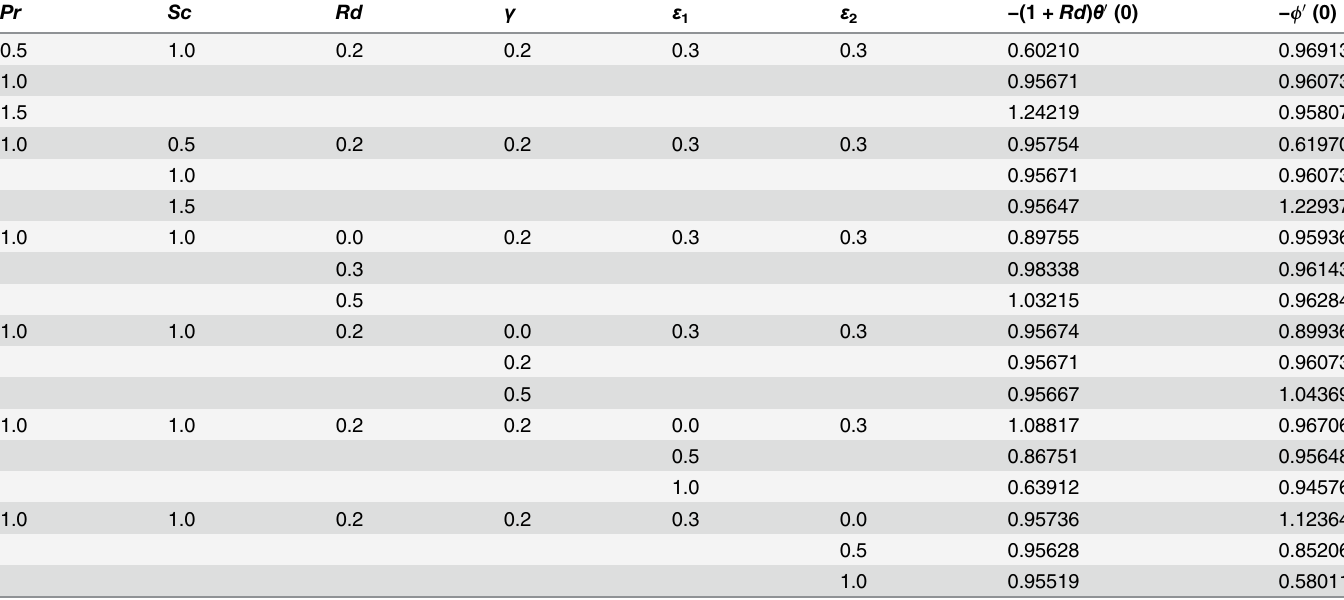
Table 3. Values of local Nusselt number (Re x ) − 1/2 Nu x and local Sherwood number (Re x ) − 1/2 Sh x for different values of Pr, Sc , Rd , γ , ε 1 and ε 2 when β